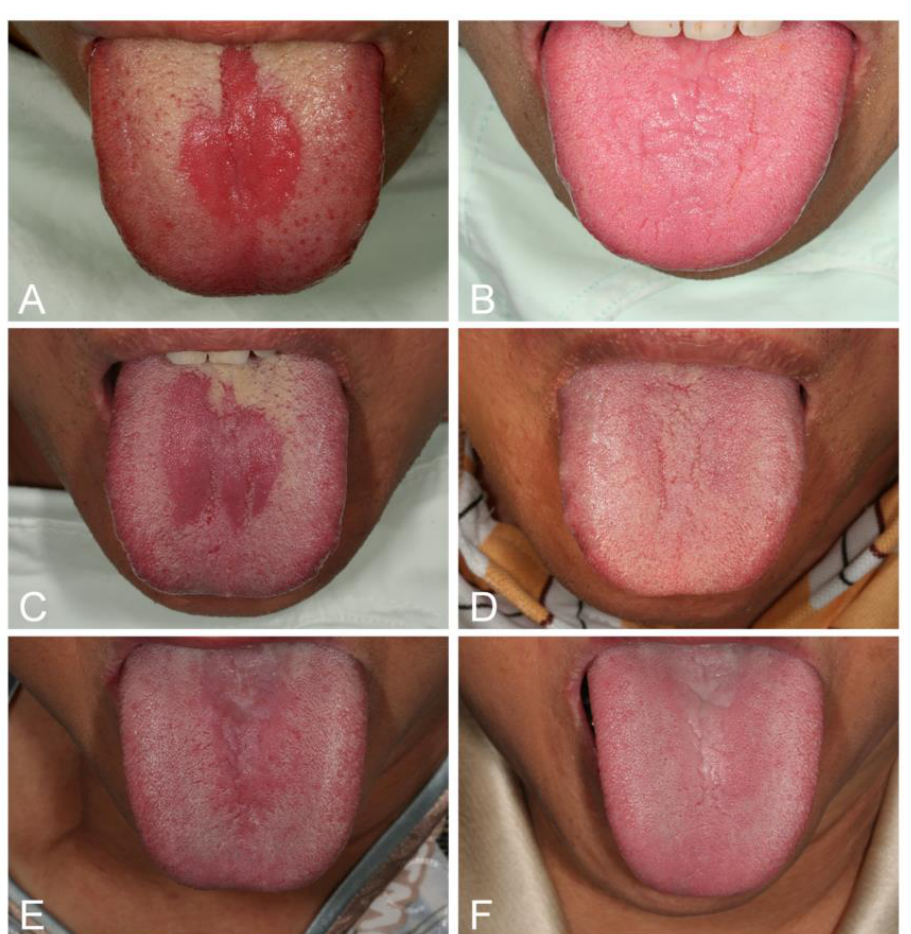
Figure 3. Median rhomboid glossitis (MRG) as a variant of erythematous candidosis ( A , C , E ) in three women with iron deficiency anemia and one of them also with diabetes. They showed complete response with regeneration of tongue papilla following iron combined with nystatin therapy 2 weeks later ( B , D , F ).